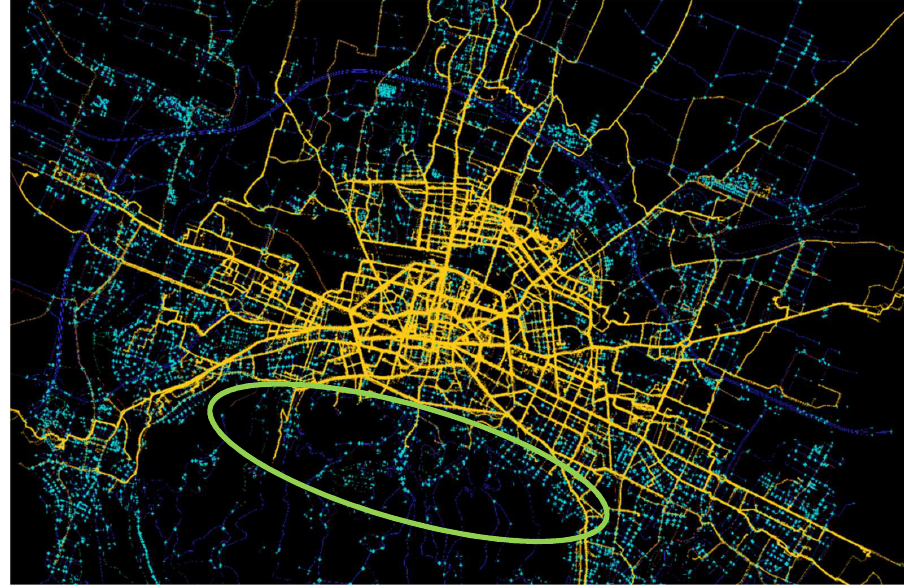
Figure 5. ECC 2016: observed cyclist activity in the Bologna network.